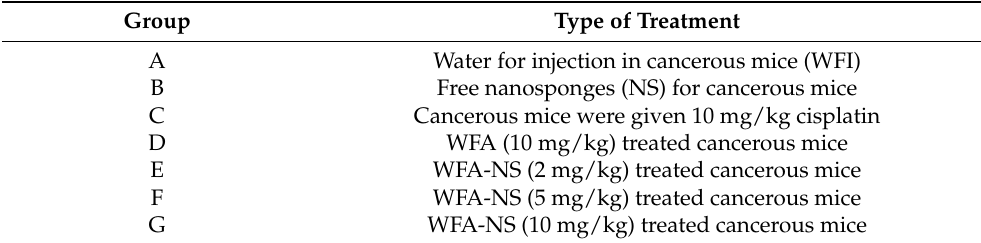
Table 3. The anticancer effects of WFA, WFA-NS, and cisplatin were shown in both experimental and comparison groups of